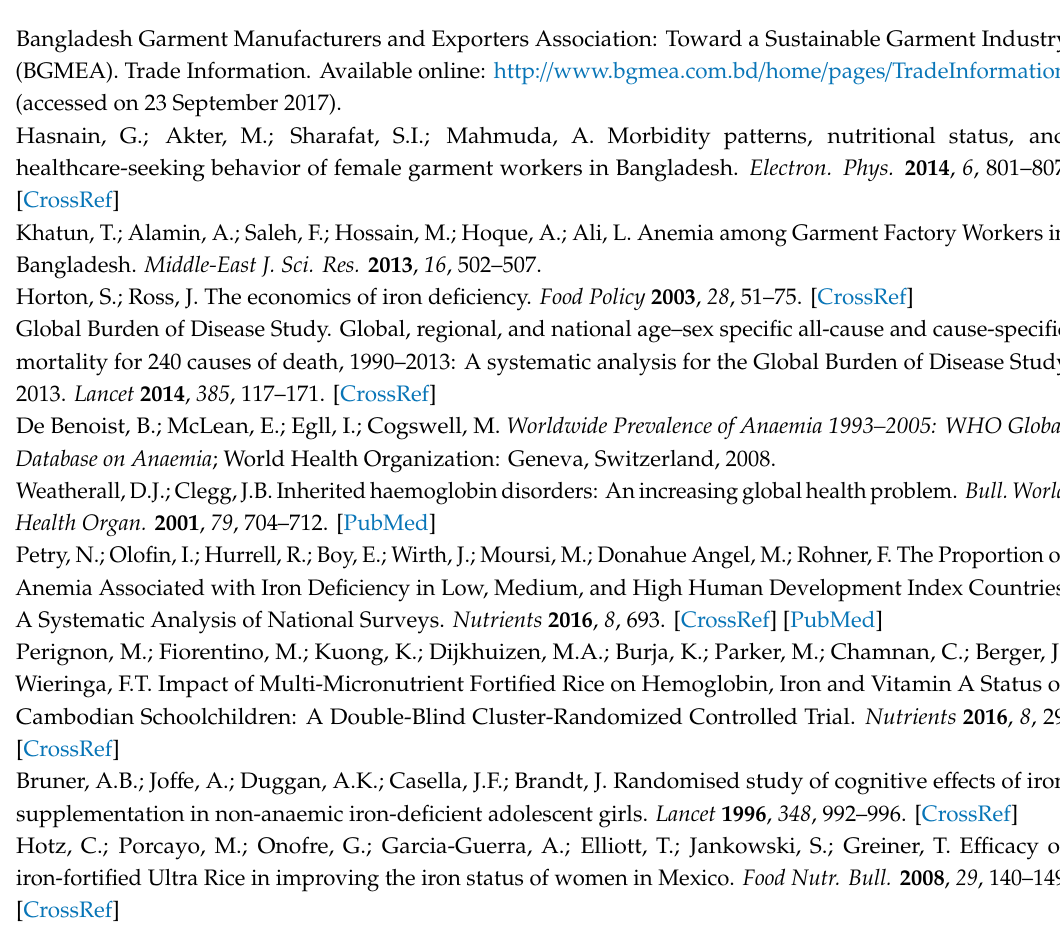
Table S1: Composition regular and fortified rice lunch meals served at readymade garment factories, Table S2: Comparison of the regular lunch menu and the fortified lunch menu to the Dietary Guidelines for Bangladesh, Table S3: Estimated energy and nutrient content of regular and fortified lunch menu served in garment factories, Table S4: Sensitivity analysis for replacement respondents at lunch meal intervention factory, Table S5: DID analysis reporting both replacement and non-replacement participant results: E ff ect of intervention on anemia reduction (% of women with any anemia), Table S6: Changes of characteristics over the baseline to the endline